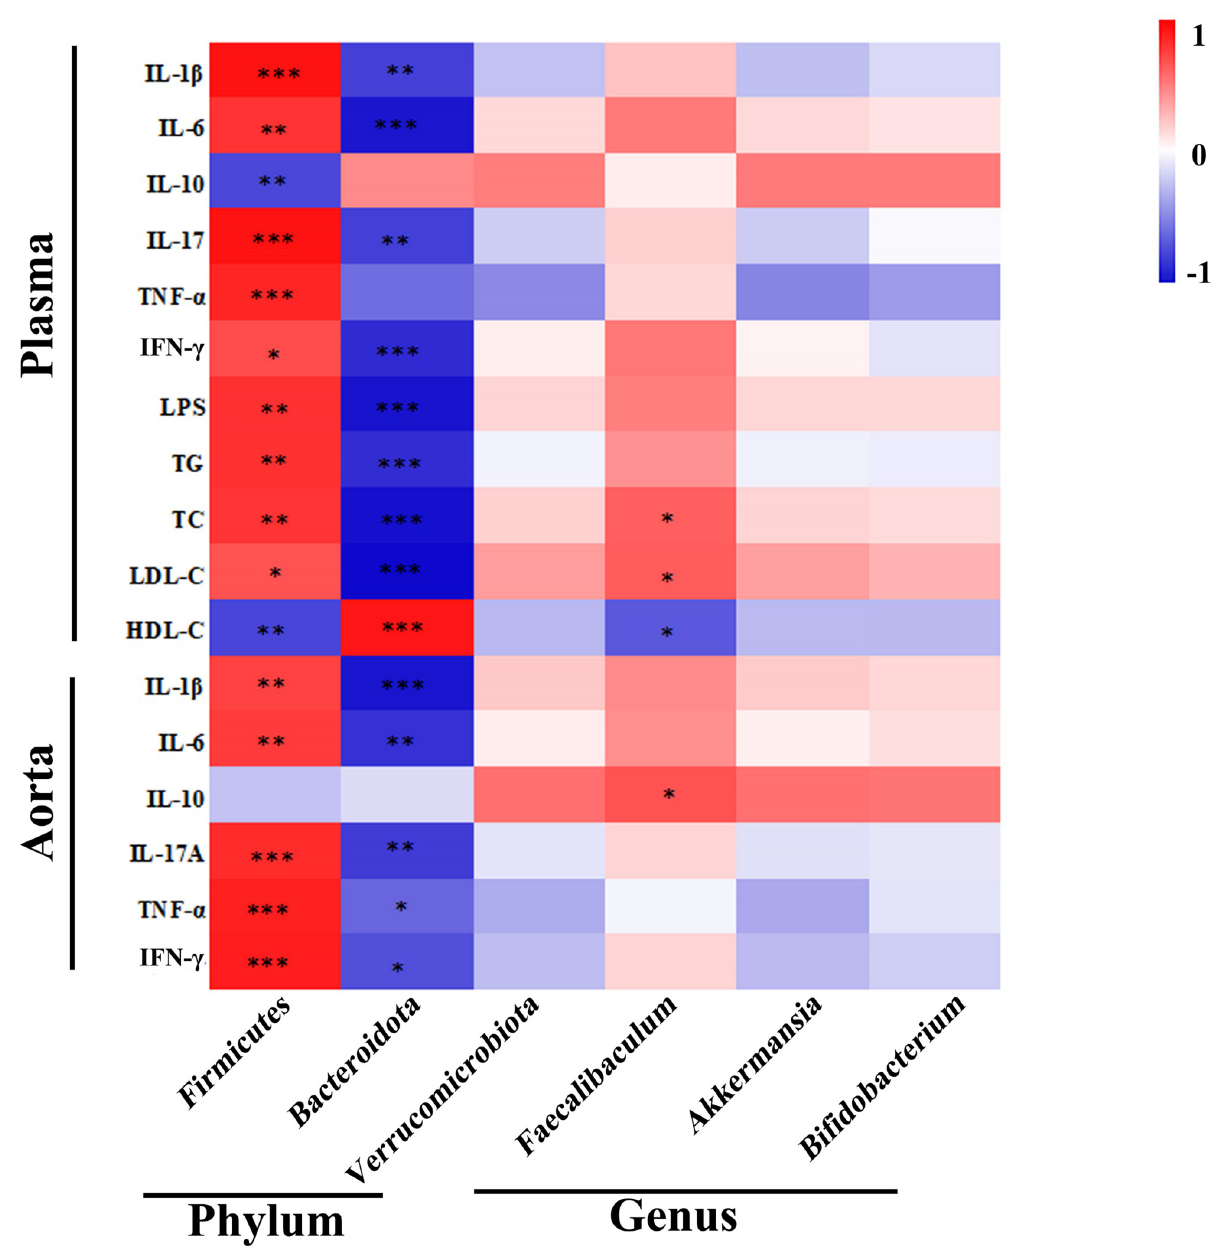
Fig 7. Altered gut microbiota in AS mice and their association with inflammatory indicators and serum lipids. The heat map showing the correlation of different microbial abundance with inflammatory indicators and serum lipids. The intensity of the color indicates the degree of correlation between the corresponding factor and each microbial species, which is obtained by Spearman’s correlation analysis. � P < 0.05, �� P < 0.01, ��� P <